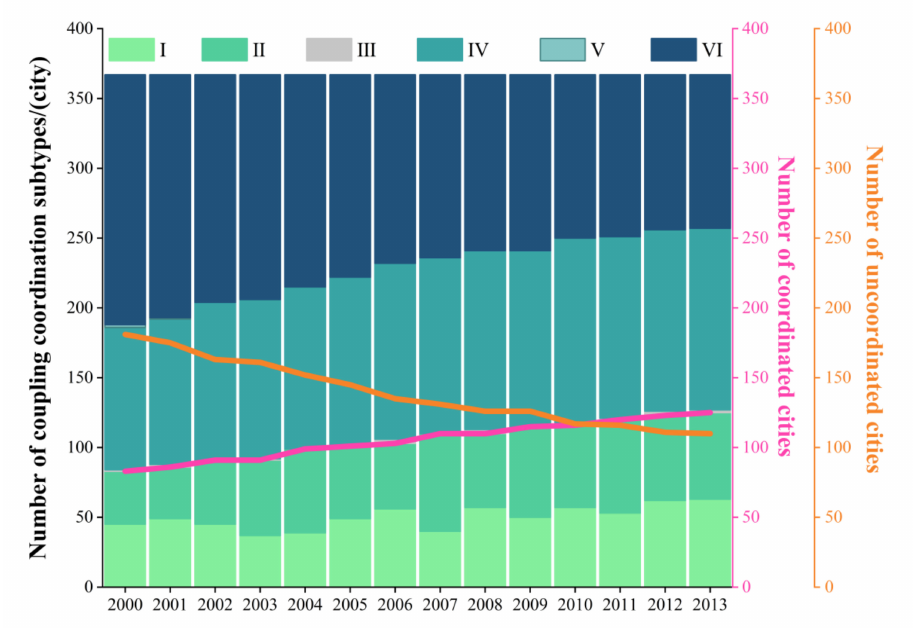
Figure 12. The statistical graph of the number of cities with different CCD subtypes. (I) Coordinated: EEQ lags behind. (II) Coordinated: urbanization lags behind. (III) Primary coordinated: EEQ lags behind. (IV) Primary coordinated: urbanization lags behind. (V) Uncoordinated: EEQ lags behind. (VI) Uncoordinated: urbanization lags